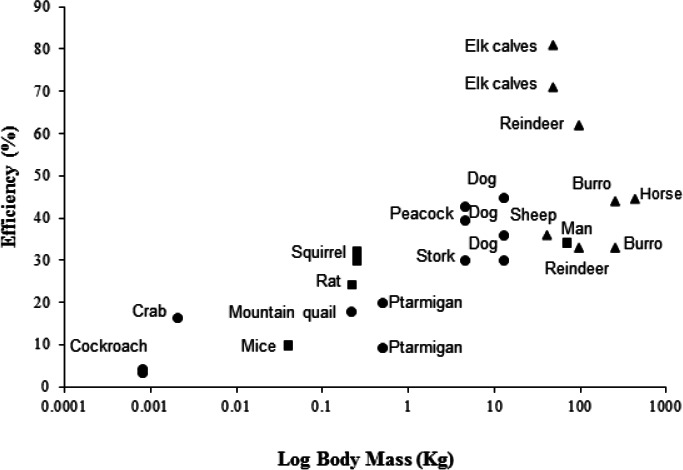
Showing the efficiencies of converting metabolic energy into mechanical work in a number of vertebrate (bipedal, depicted by blue markers; quadrupedal, depicted by red markers) and invertebrate (depicted by green markers) animals.For the studied vertebrates, foot posture is also documented (plantigrade, squares; digitigrade, circles; unguligrade, triangles). Inclines range from 2.9°to 90°. Multiple data points at the same body mass indicate the use of more than one incline in the study. Efficiency data was taken from the literature from the following sources: Burro, Equus esinus (Yousef, Dill & Freeland, 1972); cockroach, Periplaneta americana (Full & Tullis, 1990); dog, Canis familiaris (Raab, Eng & Waschler, 1976); elk calves, Cervus canadensis elsoni (Cohen, Robbins & Davitt, 1978); ghost crab, Ocypode quadrata (Tullis & Andrus, 2011); horse, Equus caballus (Wickler et al., 2000); man, Homo sapien (Taylor, Caldwell & Rowntree, 1972); mice, Mus musculus (Snyder & Carello, 2008); mountain quail, Oreortyx pictus (Snyder & Carello, 2008); ptarmigan, Lagopus muta hyperborea (Lees et al., 2013); rat, Rattus norvegicus (Snyder & Carello, 2008); reindeer, Rangifer tarandus groenlandicus (White & Yousef, 1978); sheep, Oryes aries (Clapperton 1964); squirrel, Tamiasciurus hudsonicus (Wunder & Morrison, 1974); stork, Leptoptilus crumeniferous (Bamford & Maloiy, 1980). Data for the peacock (Pavo cristatus) is from the present study. Numerical values and angles of inclination used are provided in supplementary material Table S2.